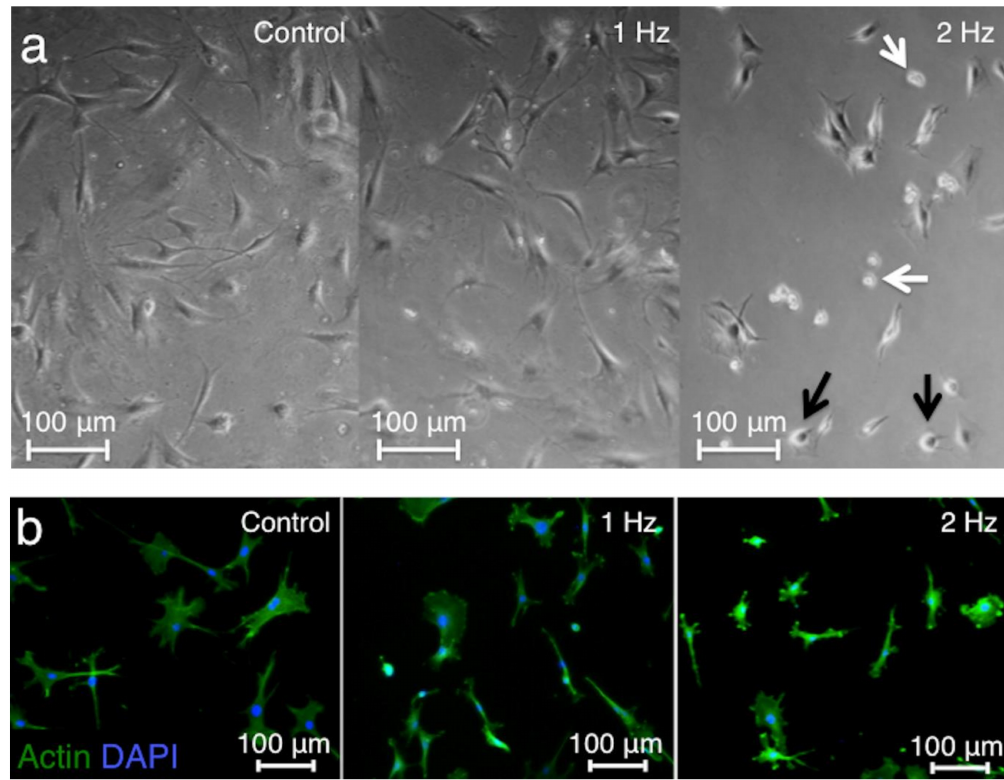
Figure 1. Cell morphology at di ff erent tensile frequencies. Cell morphology on light microscopy in the three groups: tenocytes cultured without stretching (control), with stretching at 1 Hz, and with stretching at 2 Hz. A 2 Hz stretch of the cells led to rounded cell shape (black arrows) and floating cells (white arrows) ( a ). Comparison of representative fluorescence stained sections of the three groups depicting F-actin with phalloidin-Alexa 488 (green) ( b ). Cell nuclei were counterstained with DAPI (blue). 5% stretch was applied for 3 h.